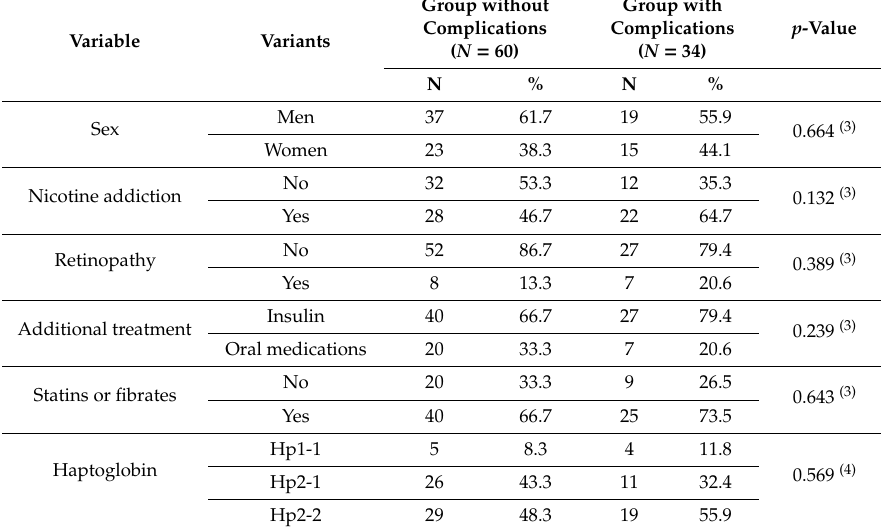
Table 3. Classification of physical chemistry parameters in patients with type 2 diabetes due to cardiovascular complications. Frequency analysis of quantitative variables. Non-parametric analysis with the Mann–Whitney U